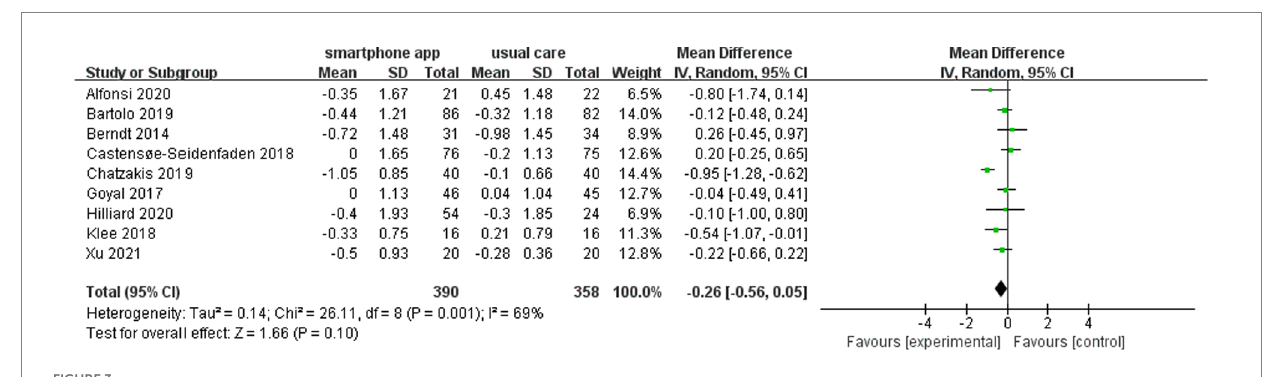
FIGURE 3 Forest plot of smartphone app intervention and change in